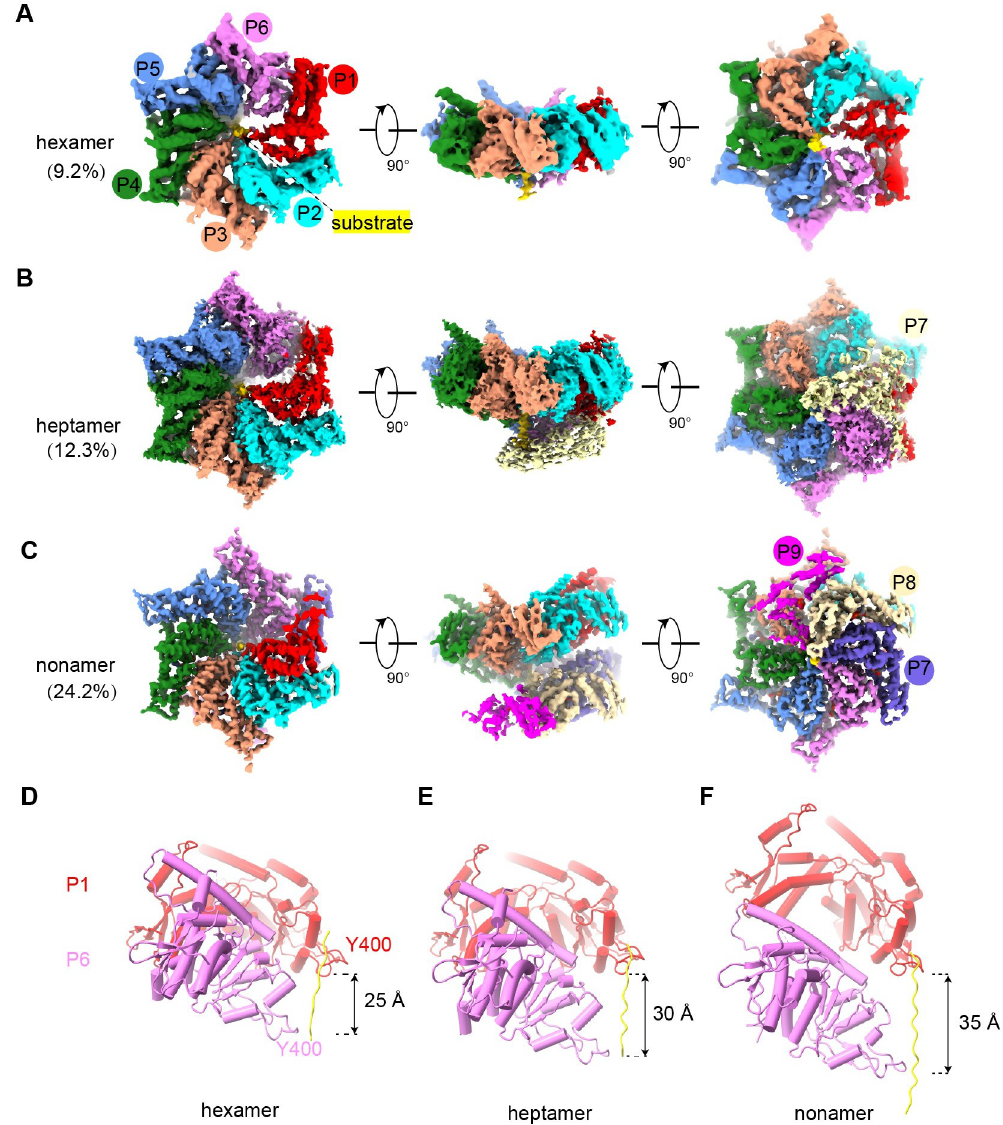
Fig 4. Cryo-EM characterization of the NBD helical structures of CLPB. ( A–C ) Density maps of the NBD hexamer (A), heptamer (B), and nonamer (C), respectively. Protomers are painted in different colors. ( D–F ) Distances along the central substrate between the PL residue Y400 of P1 and P6 in the hexamer (D), heptamer (E), and nonamer (F). The axial rise of P6 relatively to P1 are labeled. NBD, nucleotide-binding domain; PL, pore-loop. The central channels of all 3 states are occupied by a peptide substrate, which forms succes- sive interactions with the helically arranged CLPB protomers (Fig 4A–4C). In the nonamer, 9 protomers form a 1.5-turn helix around the central substrate. Besides the protomer number, the 3 oligomers also show obvious structural differences. While the twist angle between neigh- boring subunits is roughly 60˚ in all 3 forms, the axial rise within each oligomer is not constant and varies in the hexamer and heptamer largely. The axial displacements between P1 and P6 are roughly 25 Å , 30 Å , and 35 Å for the hexamer, heptamer, and nonamer, respectively (Fig 4D–4F). This is expected, as more axial space is required to fit in the seventh and more